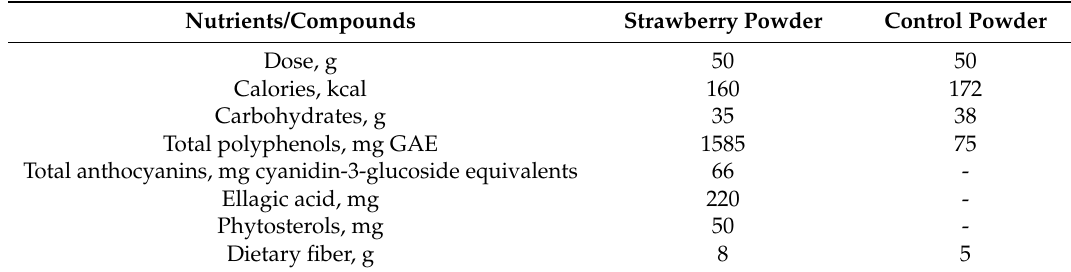
Table 1. Composition of the freeze-dried strawberry and control powders 1